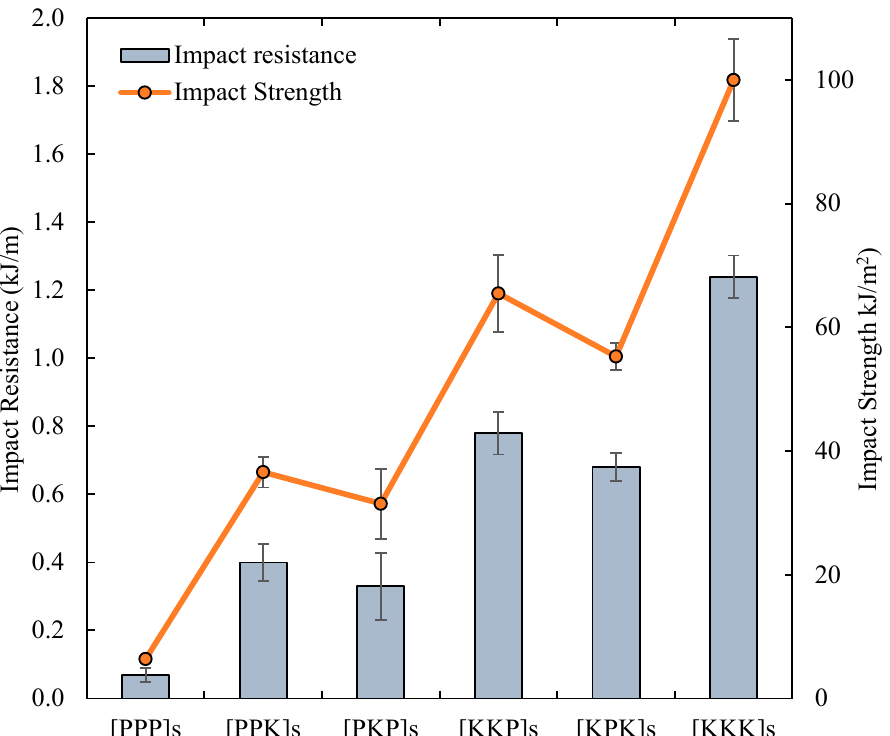
Figure 9. The impact resistance and impact strength of PALF/Kevlar-reinforced UP hybrid composite laminates with different stacking sequences.